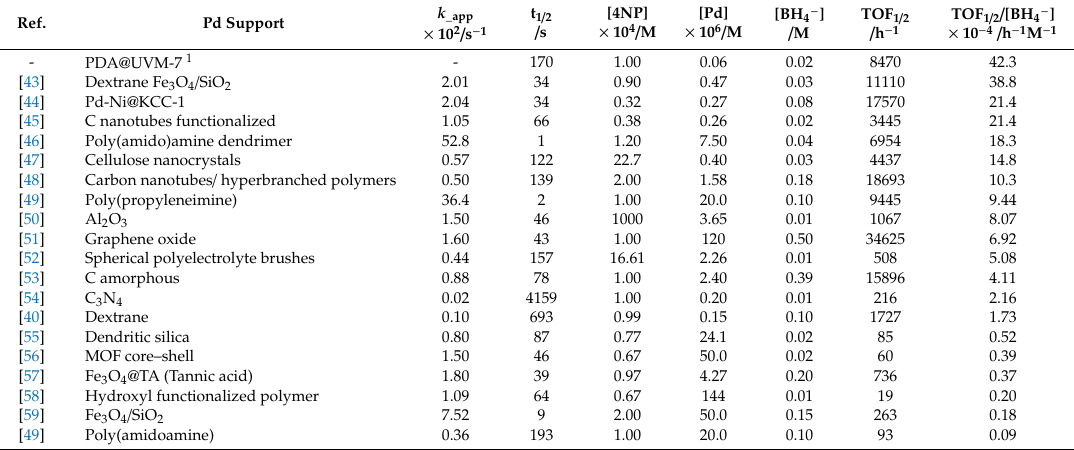
Table 4. TOF 1 / 2 for diverse supported / stabilized Pd NPs